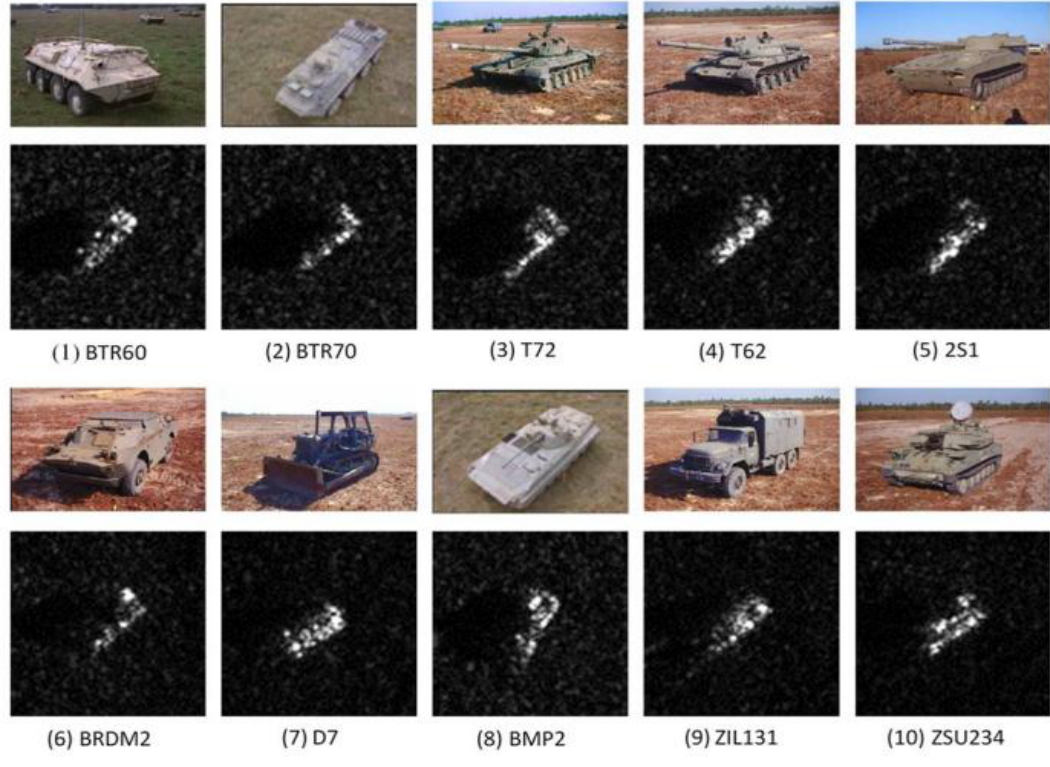
Figure 4. Examples of the ten class SAR targets. Table 2. Type and sample number of training and testing set.